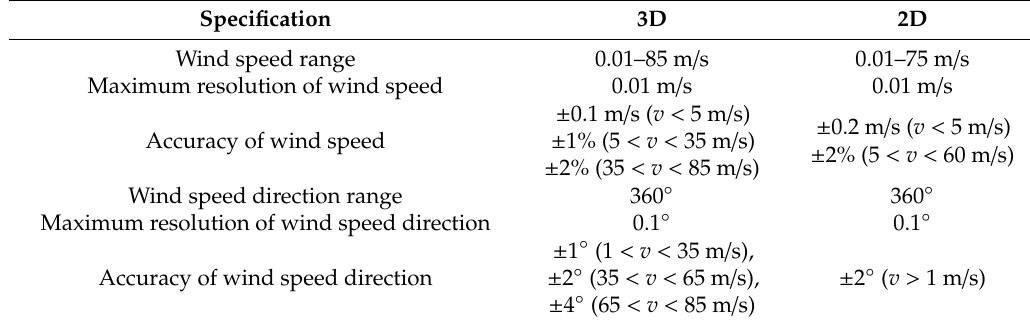
Table 1. Basic anemometer specifications. 2D, two-dimensional; 3D, three-dimensional.